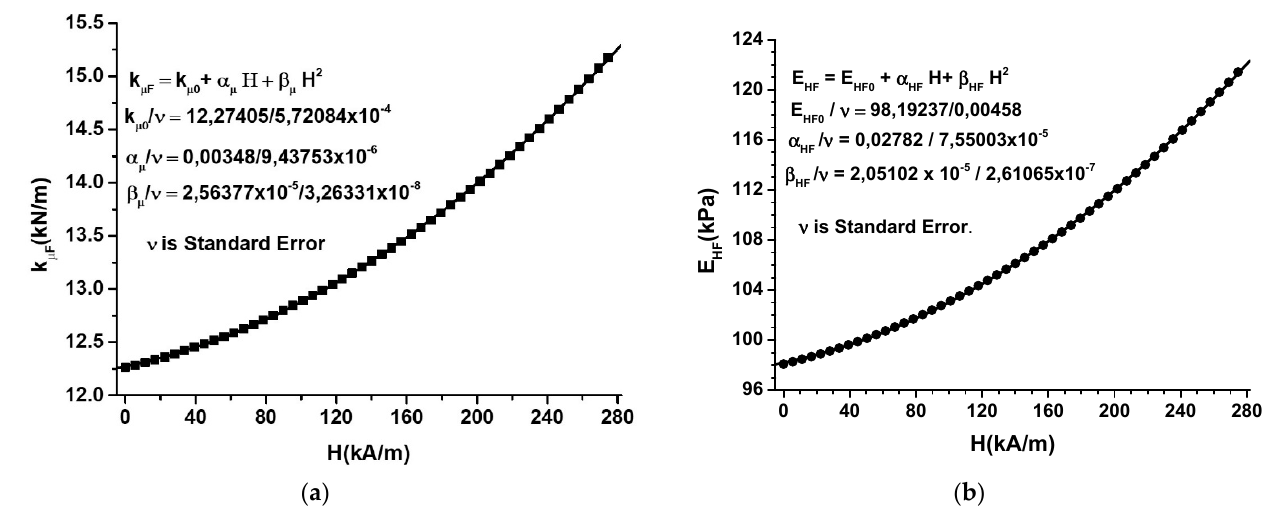
Figure 16. ( a ) The variation of the elastic constant of MPS, k µ F , as a function of the magnetic field intensity, H; ( b ) the variation of Young’s modulus, E HF , as a function of the magnetic field intensity, H.